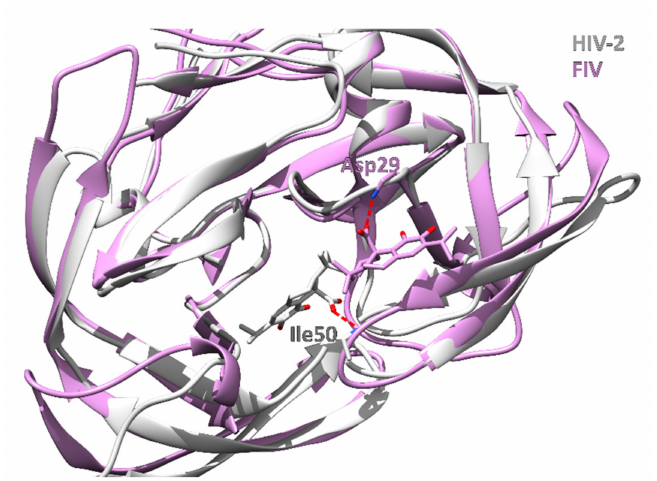
Figure 5. Comparison of HIV-2 (grey cartoon) and FIV (purple cartoon) protease. Carnosic acid in HIV-2 binds deep into the protease binding site and forms a hydrogen bond with the backbone nitrogen of Ile50 (red dotted line). On the other hand, carnosic acid is located closer to the protease surface in FIV and forms a hydrogen bond H-bond with the backbone nitrogen of Asp29 (red dotted